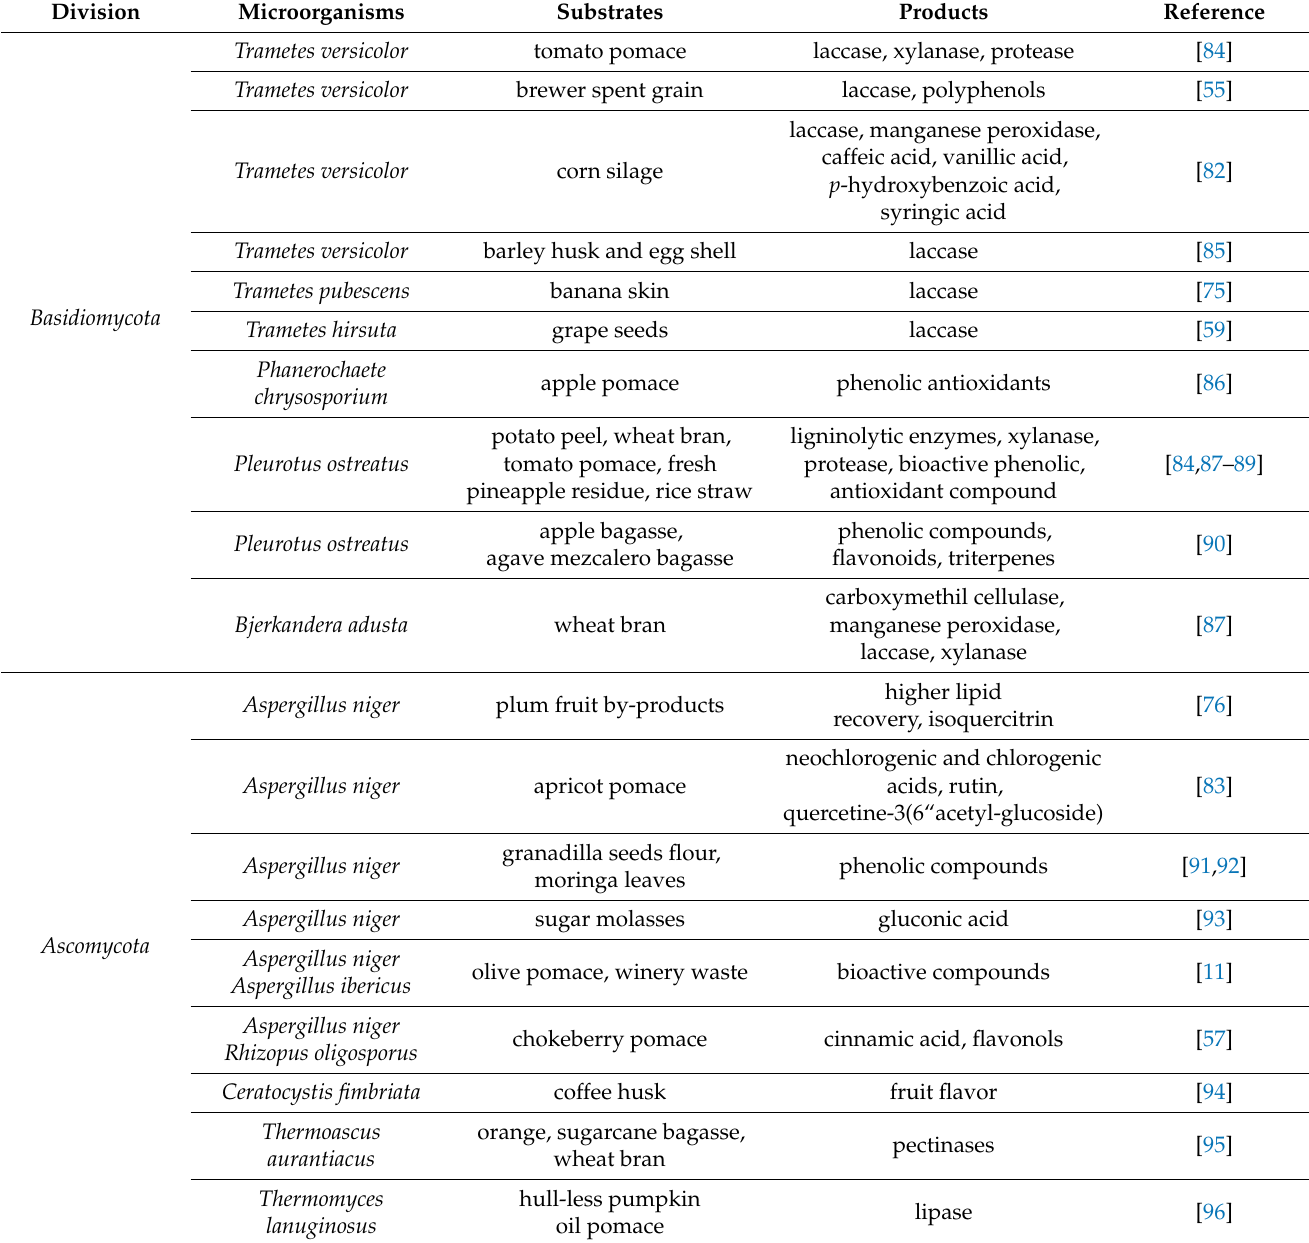
Table 3. Filamentous fungi used for the production of enzymes and other value-added products during SSF on different food industry waste or